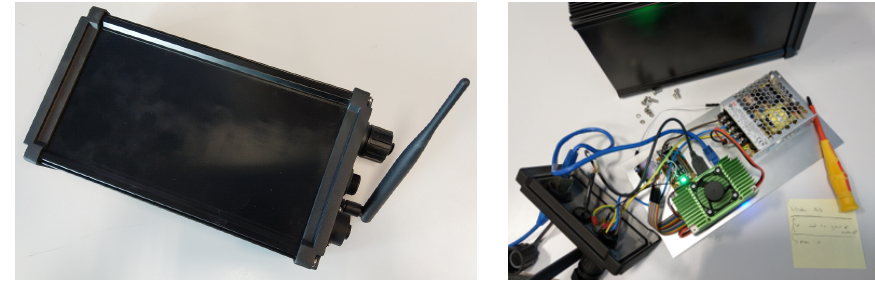
Figure 2. The smart visual sensor, outside and